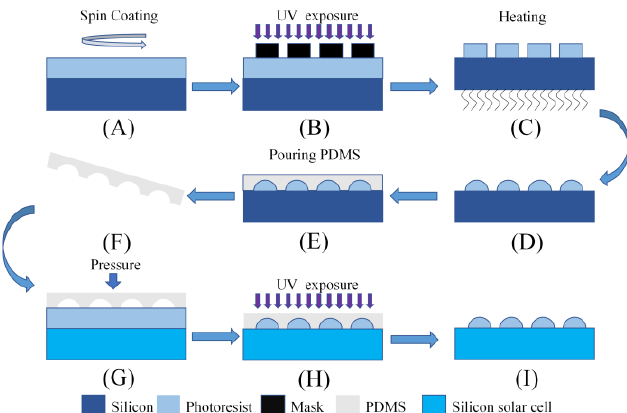
Figure 2. Flow chart of the manufacturing process of the photoresist film MLAs on silicon solar cells. ( A ) Spin coating photoresist film on this silicon substrate, ( B ) exposure of the photoresist film to the UV light with Ge mask, ( C ) thermal reflow, ( D ) original photoresist mold, ( E ) replicating PDMS mold, ( F ) peeling off this mold, ( G ) pressing a PDMS mold on this photoresist film, ( H ) exposing this sample for solidification, ( I ) obtained silicon solar cells with MLAs.